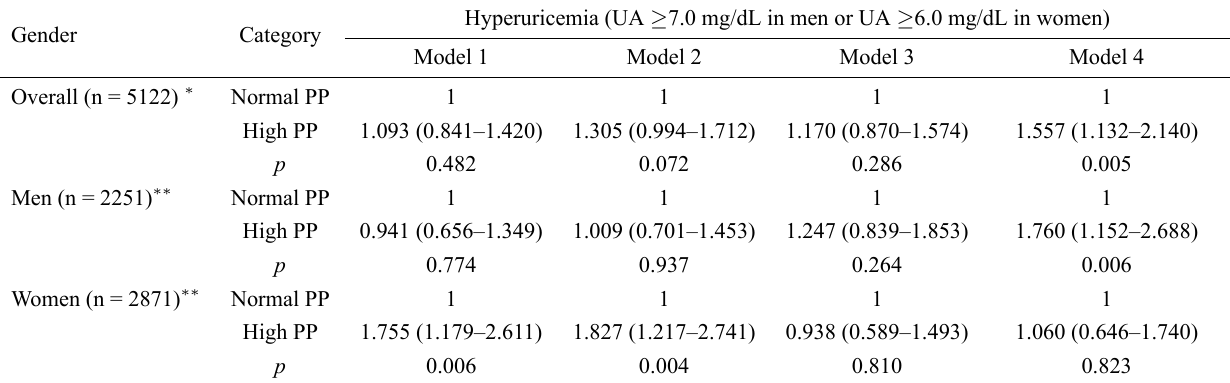
Table 5. Comparisons of hyperuricemia and high pulse